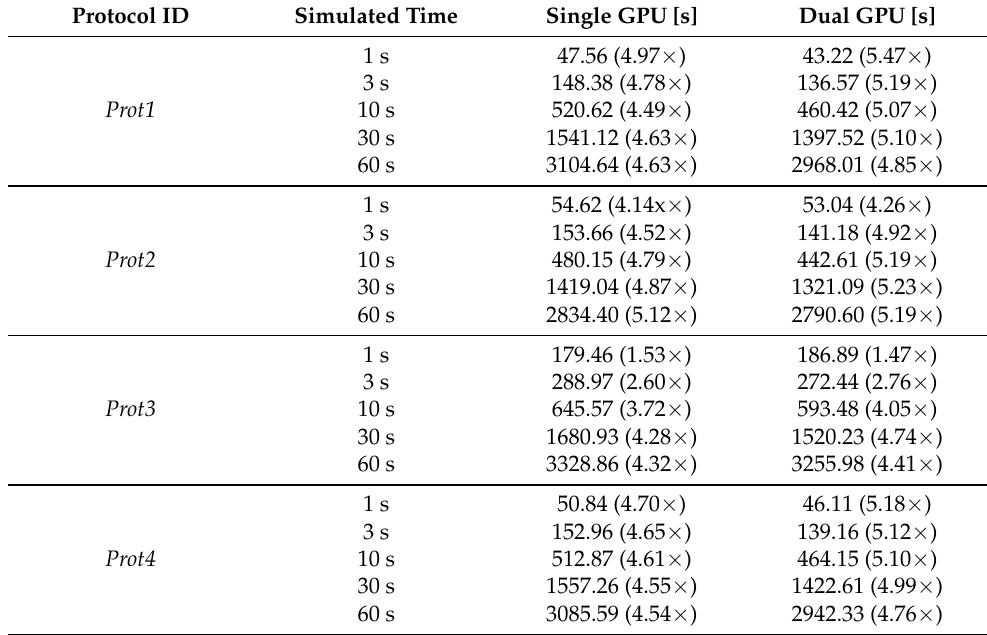
Table 6. Processing time for the network Network1 . The speed-up is indicated between brackets.